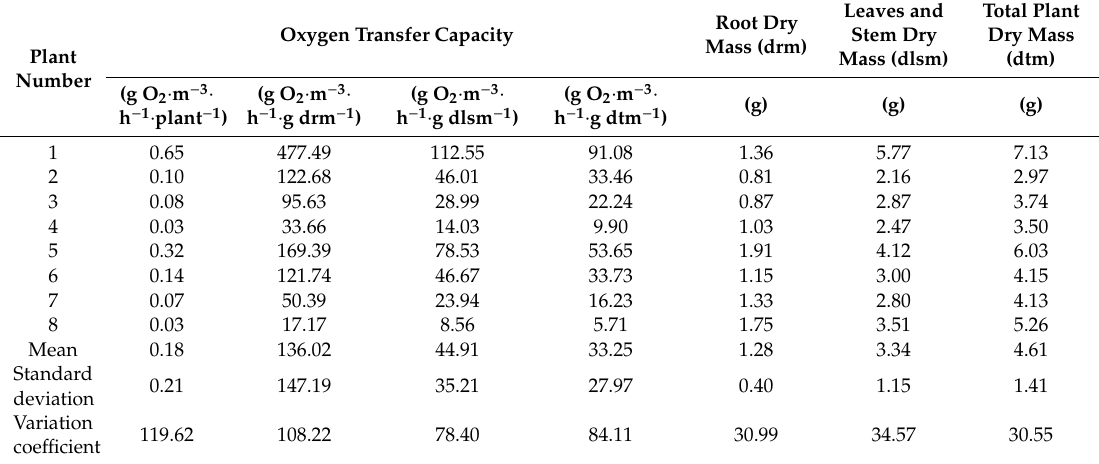
Table 1. Measured oxygen transfer capacity and morphometric parameters of individual plants used in the